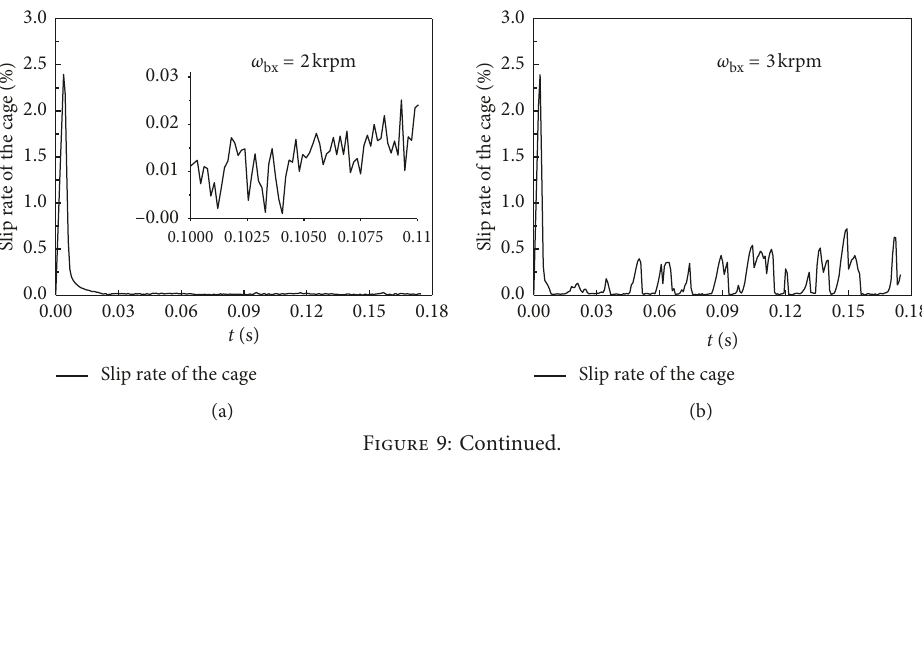
Figure 8: The slip rate of the conical roller. F